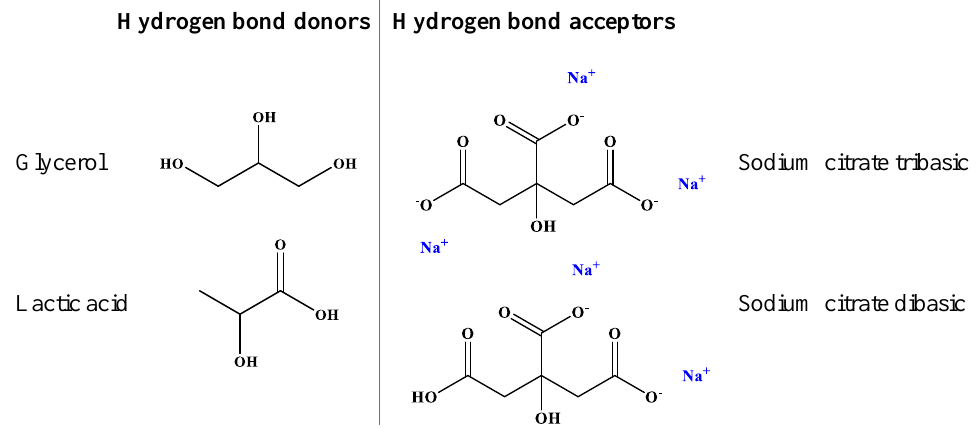
Figure 1. Hydrogen bond donors (HBD) and hydrogen bond acceptors (HBA) tested in the current Hydrogen bond donors (HBD) and hydrogen bond acceptors (HBA) tested in the investigation. current